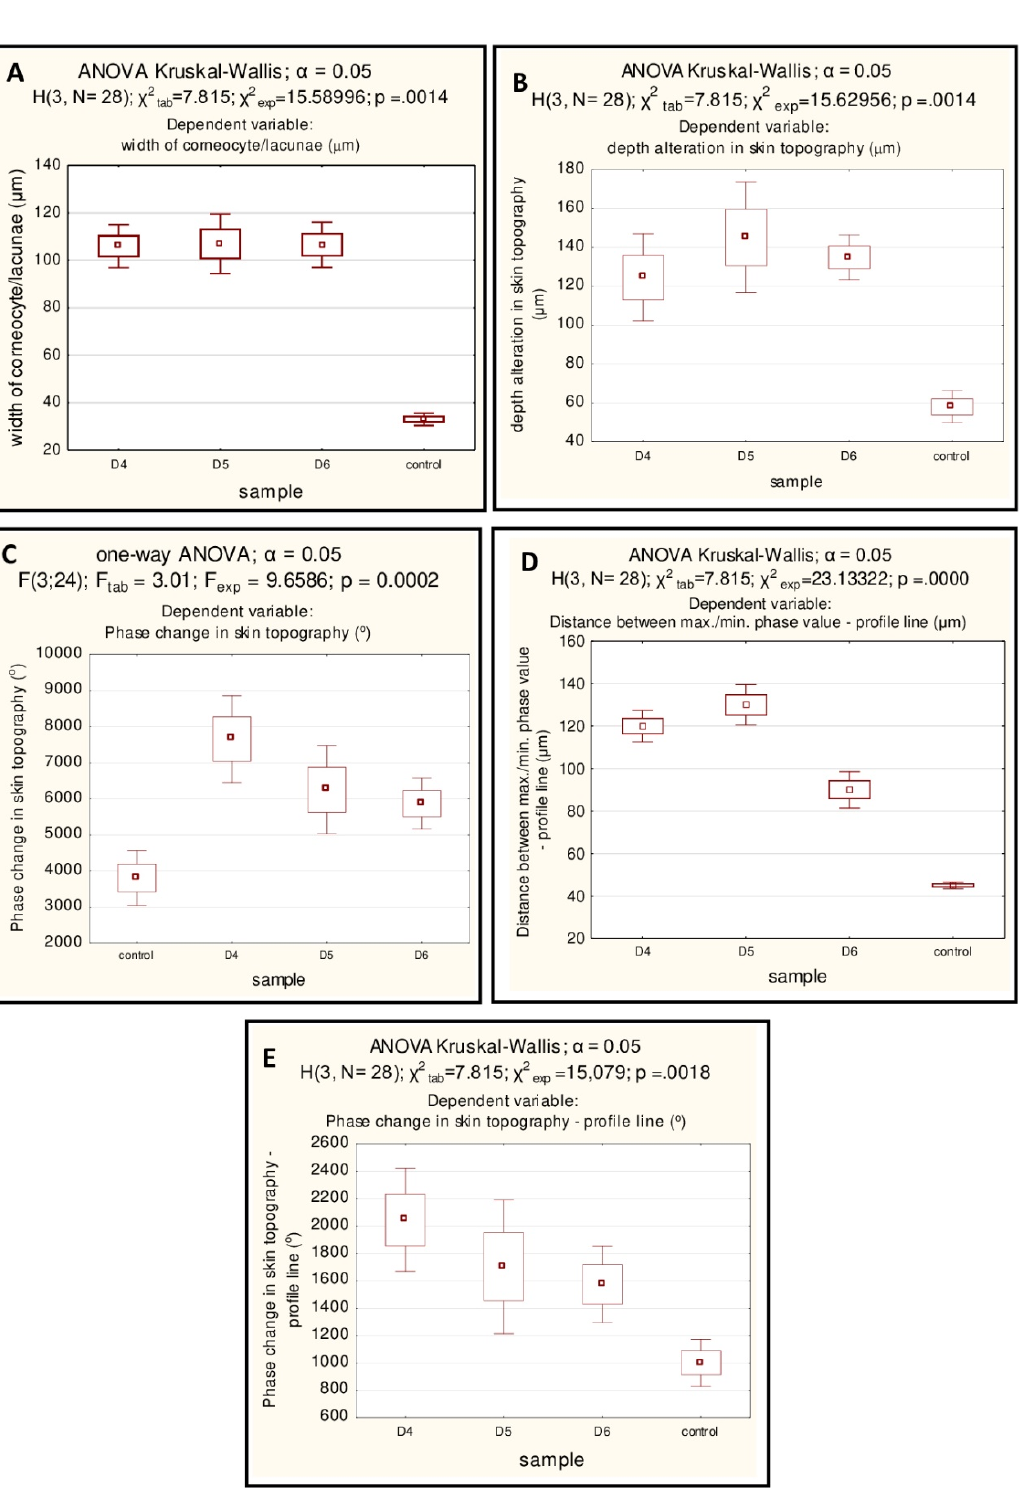
Figure 4. Statistical data evaluation reflecting the stratum corneum geometrical topography and structural changes. Comparison the quantitative results after of siloxanes application with control sample: ( A )—the average widths of the corneocytes and lacunae [um], ( B )—depth alteration in skin geometrical topography, ( C )—phase differences (°), ( D )—phase change (°)—profile line, ( E )—distance between max./min. phase value (μm).